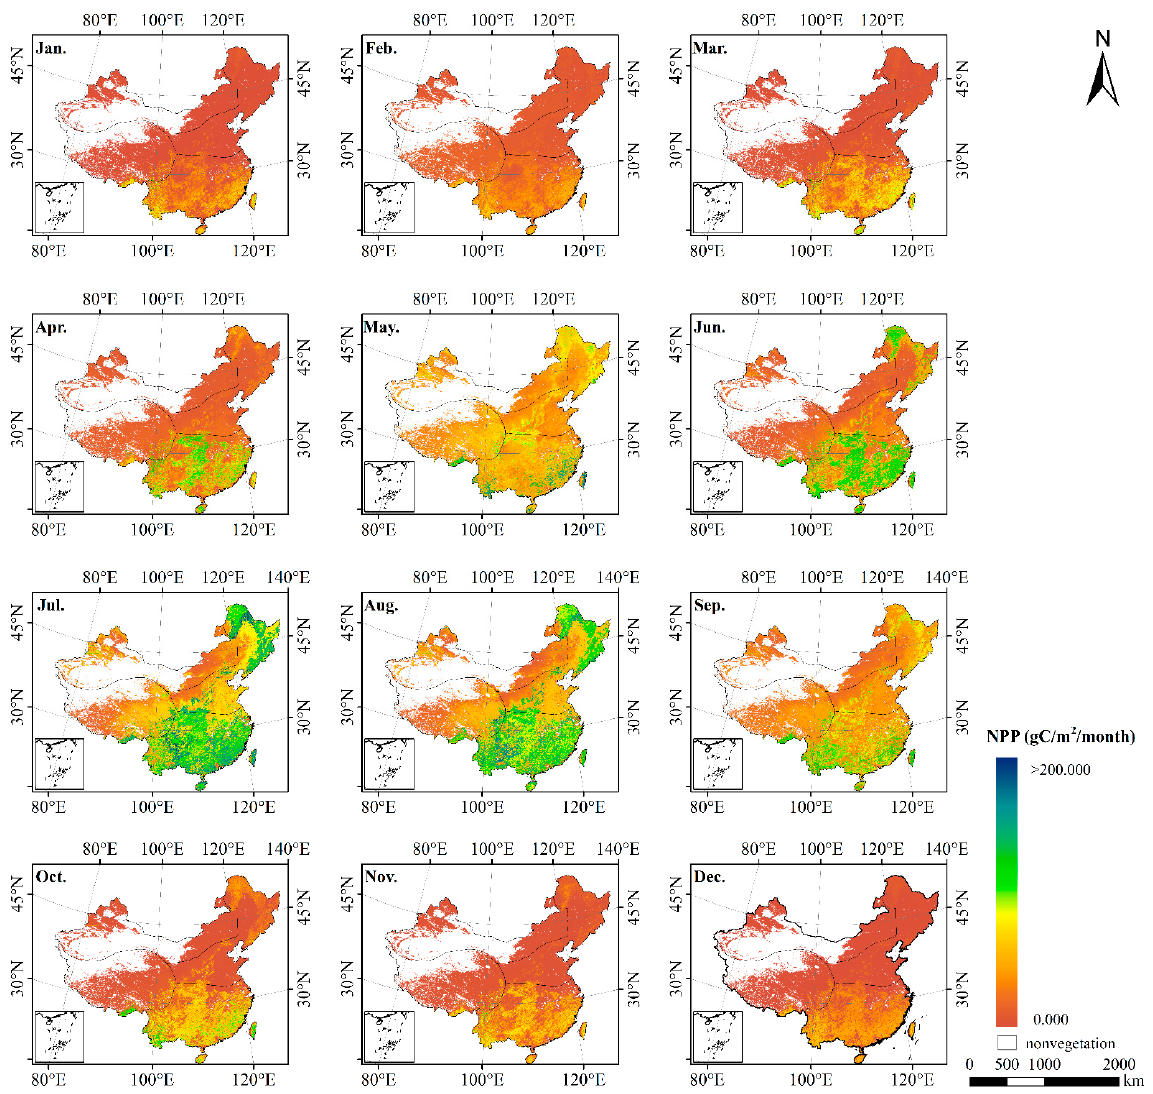
Figure 2. Spatial pattern of monthly NPP estimated over China during 2010 by the improved CASA model.